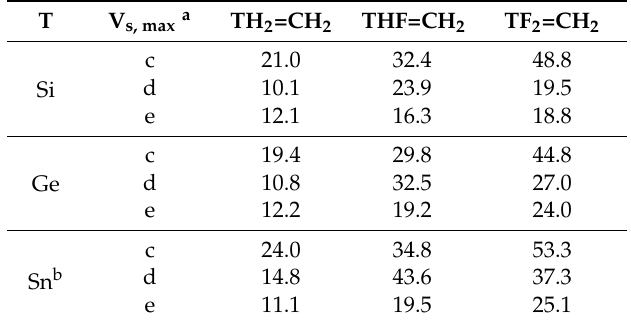
Table 2. Values of maxima in the MEPs (V s,max , kcal/mol) of TR 2 =CH 2 π -hole donors, at the MP2/aug-cc-pVDZ-PP level of